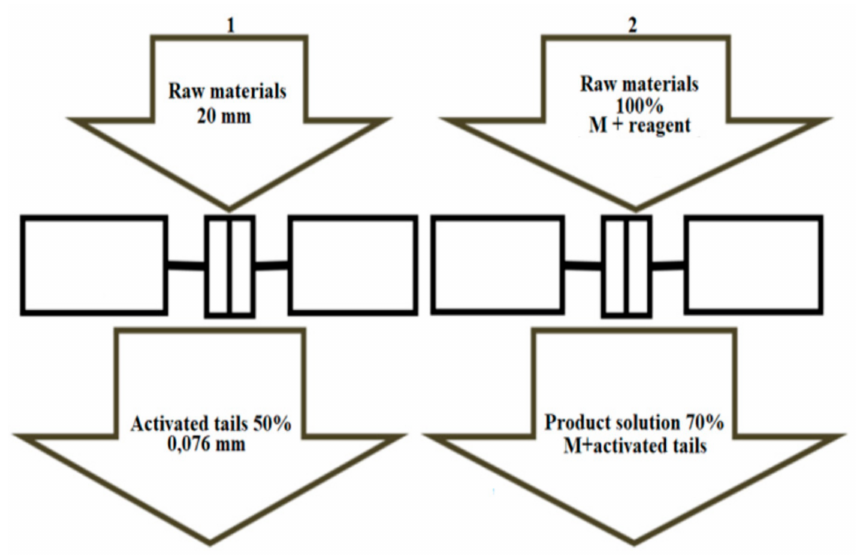
Figure 2. Using the disintegrator. 1—simple activation; 2—extraction and activation treatment. Table 1. Extraction of zinc from tailings. Activation Treatment, min.